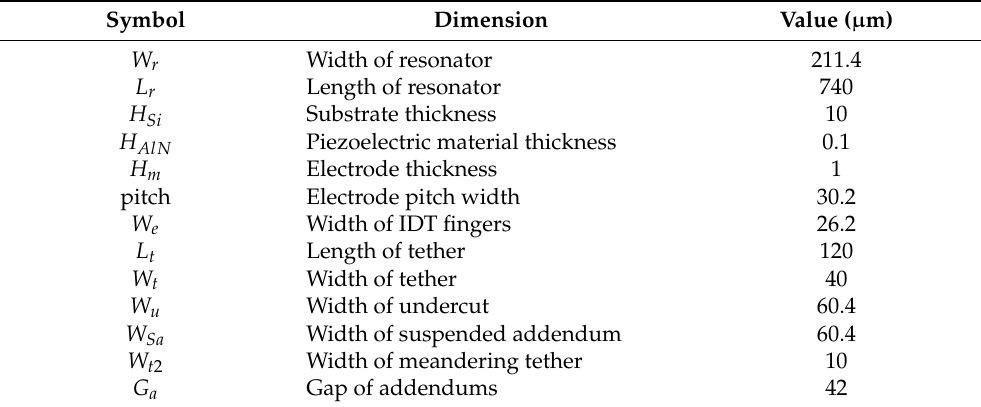
Table 1. Resonator design